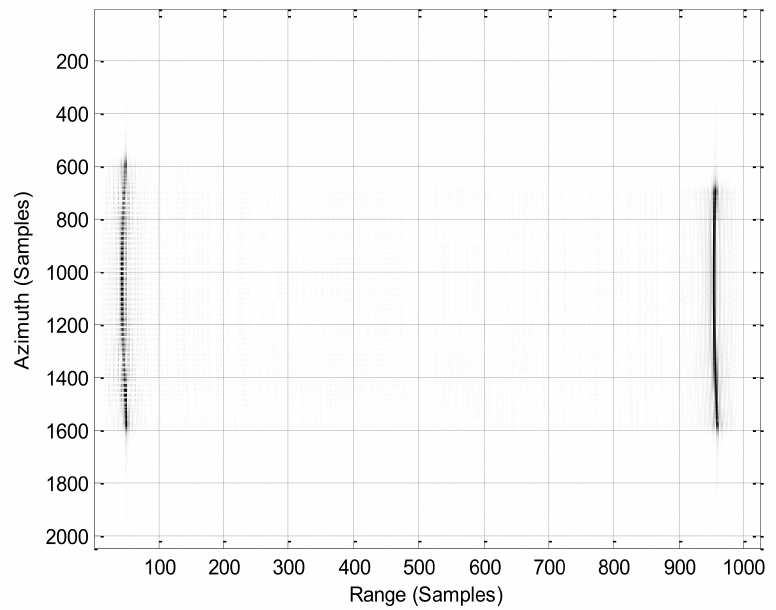
Figure 12. Range-compressed data in the range-Doppler domain by the proposed SAR processor, 2048-FFT.